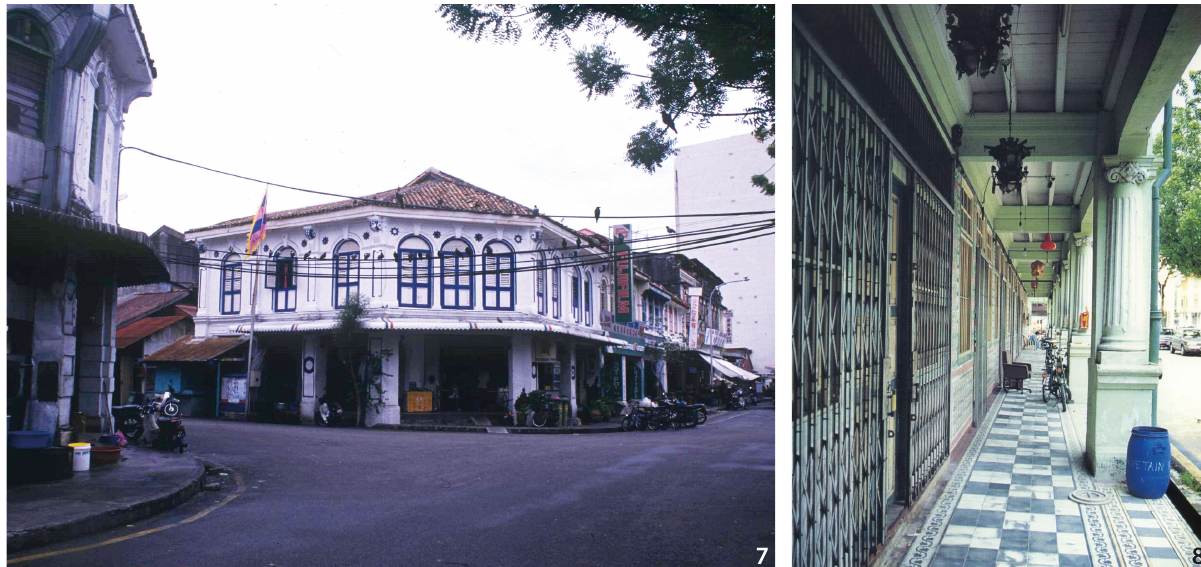
Figure 7 Community temple and Yap clan temple in Penang (Source: the author). Figure 8 The ‘five–foot way’ as the urban fabric (Source: the